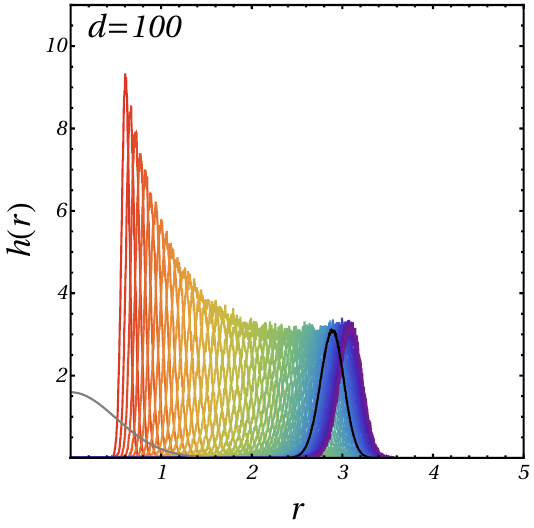
Figure 5: Biased walks in a hypercube. Each colored line is a histogram h k ( r ) of distances to the center for a random walk constrained to remain in a 100 d hyper- cube with unit sidelength, a = 0 . 5, and subjected to a biasing potential U k ( r ) = kr 2 / 2. Color encodes the value of the rigidity k , from large (red) to small (pur- ple). Here, the K = 64 spring constants are chosen so that the modes of the distribution are equally spaced (cid:112) in r , from r = a = 0 . 5 (red) to r ≈ 3 . 1 > d/ 3 a (pur- ple). A 1 d gaussian is sampled to obtain points near the center (gray line) to improve the MBAR solution. The reconstructed density of states of the cube is shown in black. Note that the 16 histograms to the right of the black line correspond to negative values of k